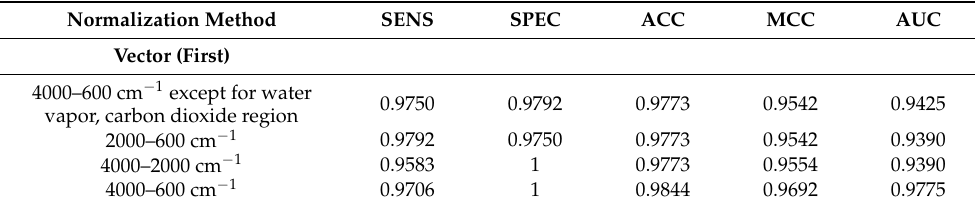
Table 5. List of permutation parameters of the random forest model obtained using variables selected by vector normalization applied after the first differentiation.